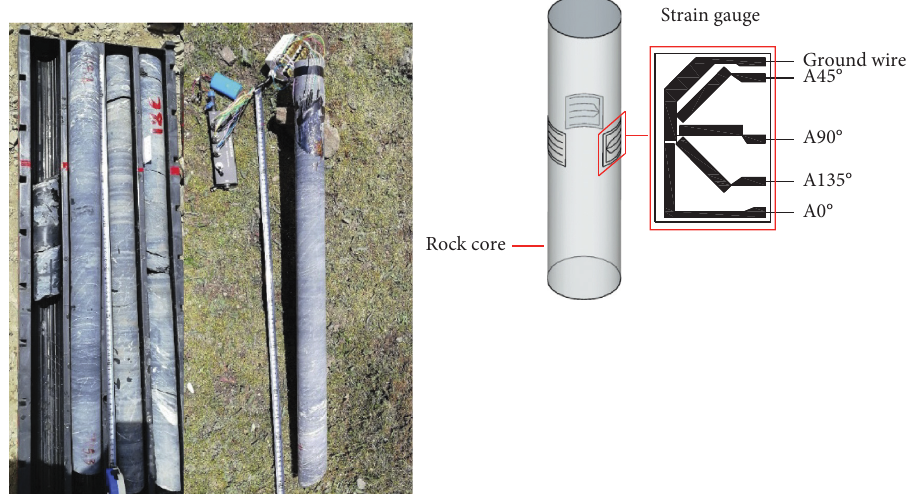
Figure 12: Arrangement of rock core strain gauge on-site.